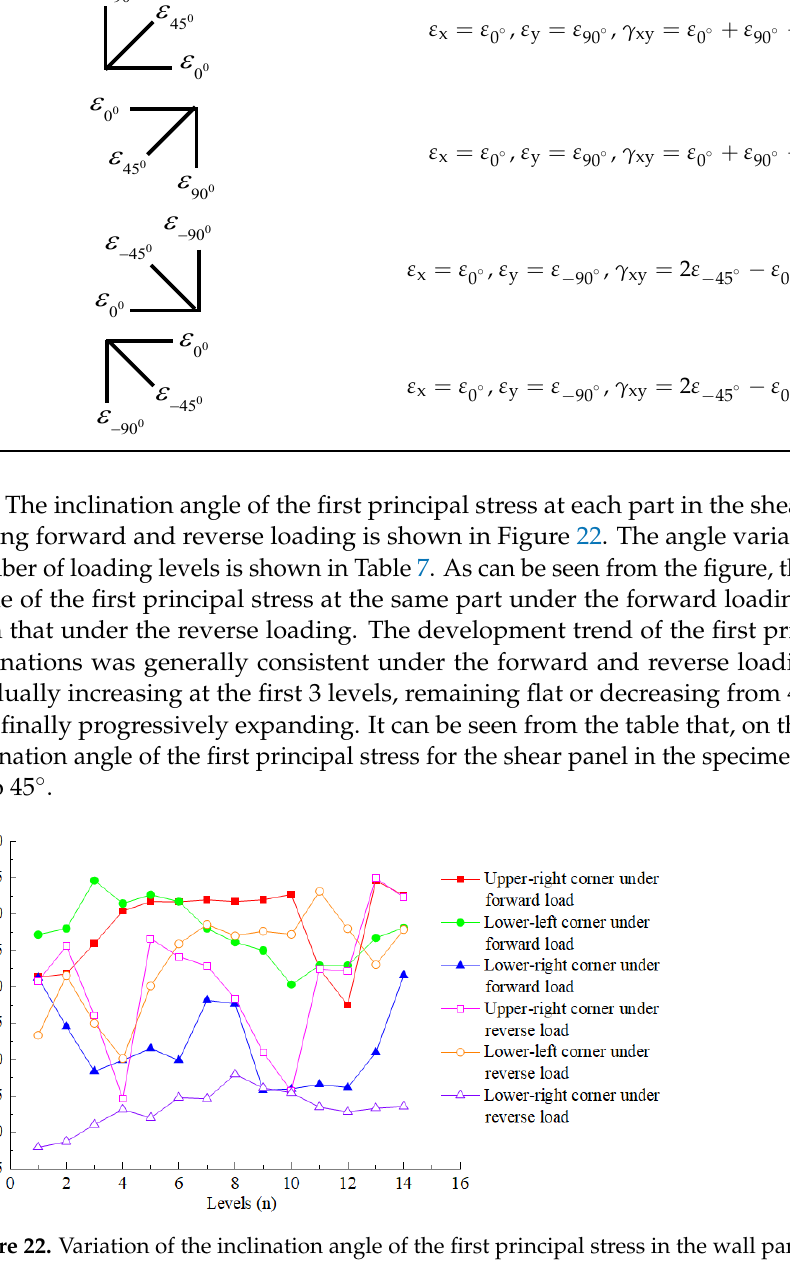
Table 6. Calculation formula of strain in the direction of strain rosette. Calculating Equations of Axial Strain ε x , ε y and Direction of Strain Rosette Shear Strain γ xy